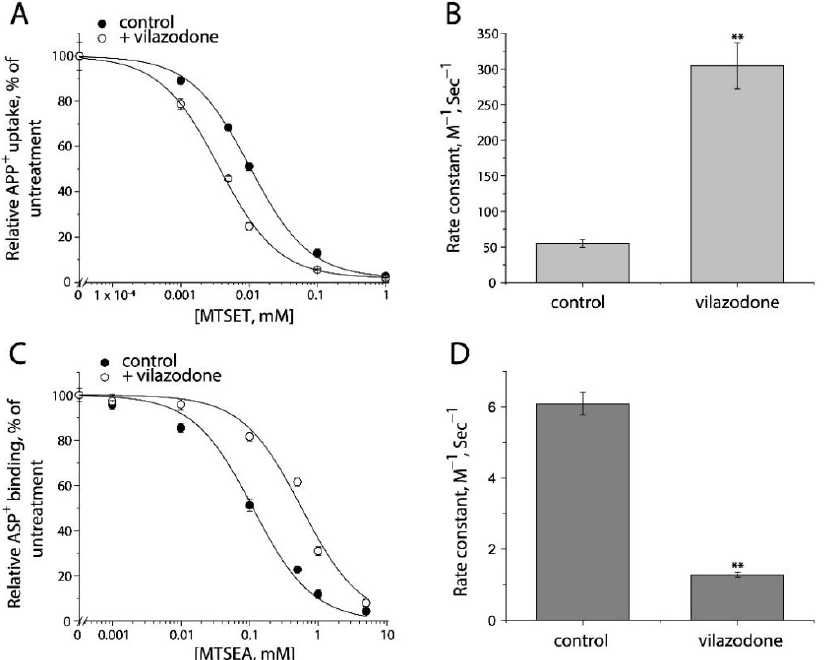
Figure 9. The effects of vilazodone on SERT conformation. ( A ) The effect of vilazodone on MTSET inhibition of APP + uptake by Y107C/C109A. The cells stably expressing Y107C/C109A were